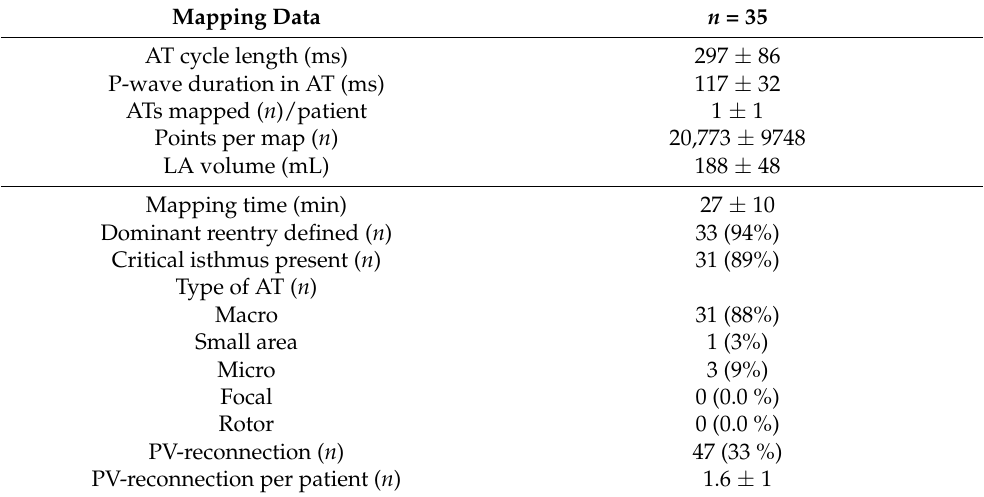
Table 3. Mapping